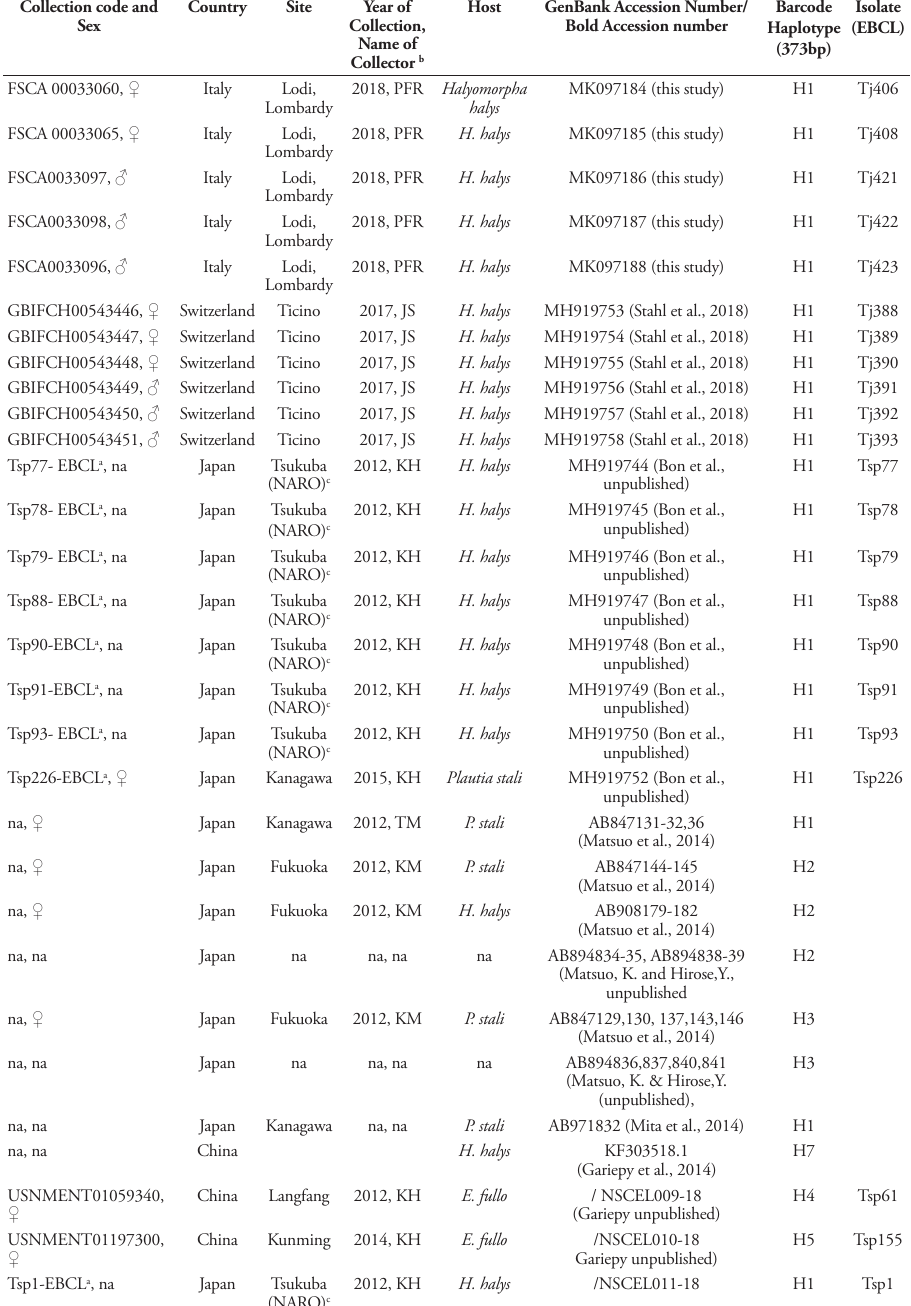
Table 4. Sampling Information, GenBank Accession numbers and haplotype for Trissolcus japonicus included in this